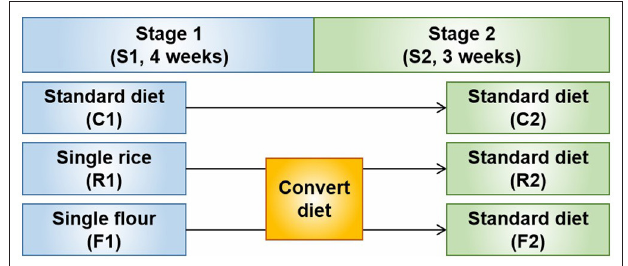
FIGURE 1 | Schematic diagram of the experimental design. Stage 1 (S1) involved treatment with a rice (R1) and flour (F1) diets. After converting the diets at Stage 2 (S2), R1 and F1 became the AIN-93 diet (R2 and F2, respectively) for 3 weeks.